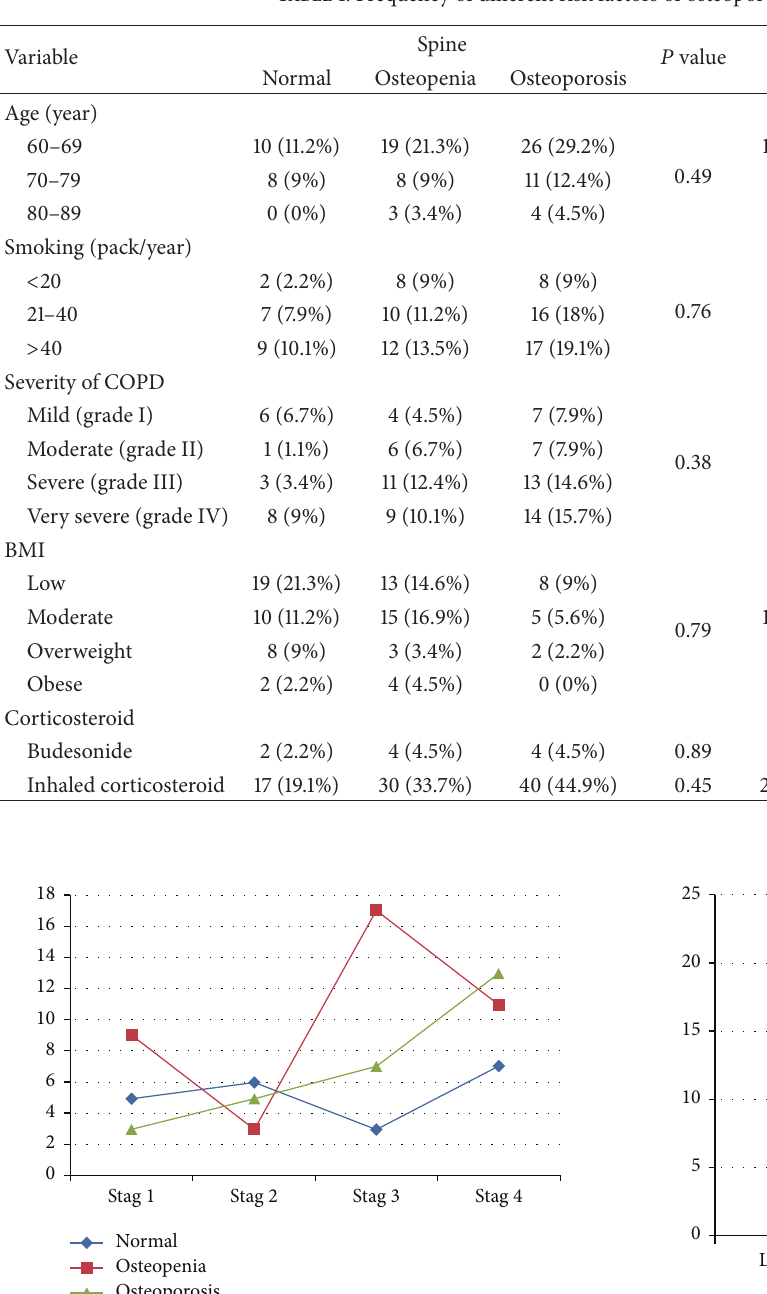
Table 1: Frequency of different risk factors of osteoporosis in COPD patients.